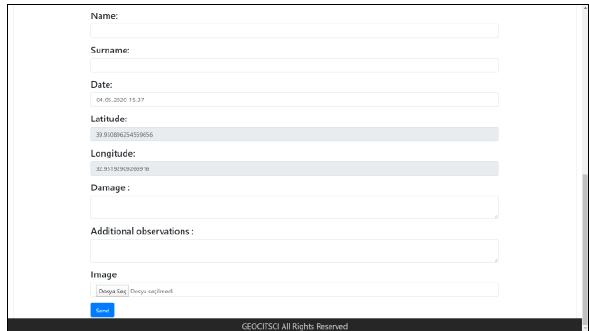
Figure 4. Landslide information form on the landslide reporting page.